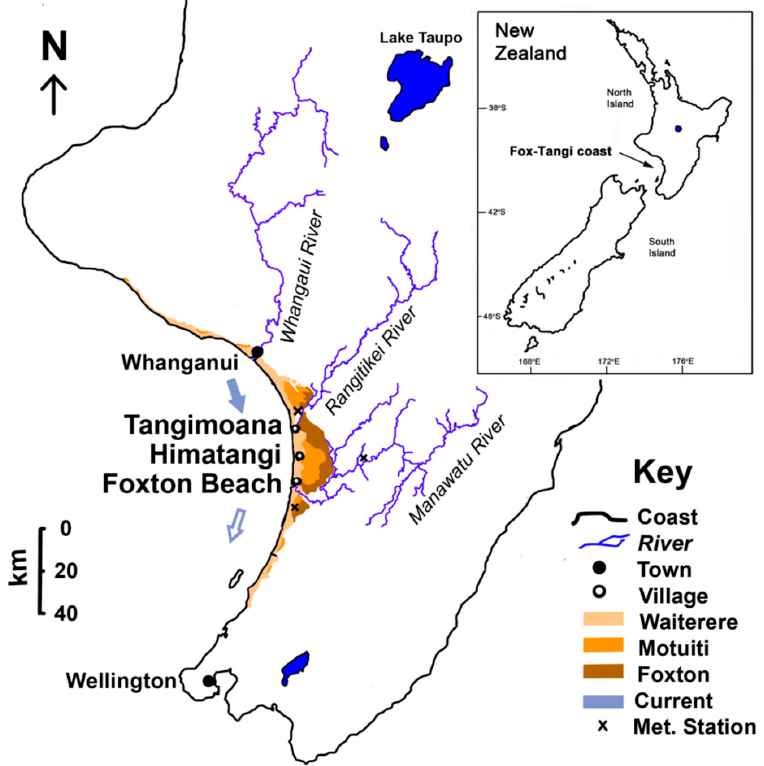
Figure 1. Location map of study sites along the Fox-Tangi portion of the Manawat¯u bight, North Island, New Zealand. Study sites are immediately south of Tangimoana and Himitangi, and north of Foxton Beach. The brown shades are the Holocene dune phases, sensu Muckersie and Shepherd [38], surrounding the study